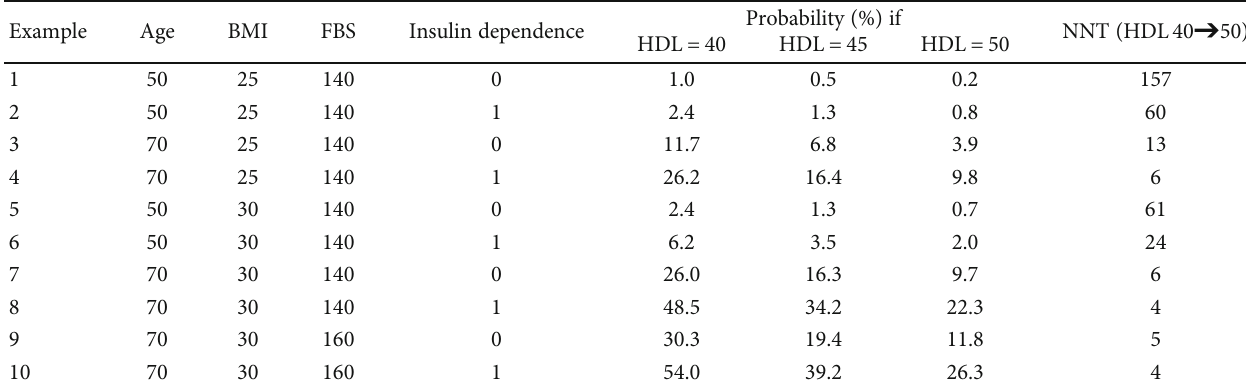
Table 2: Examples of diabetic foot ulcer prediction.